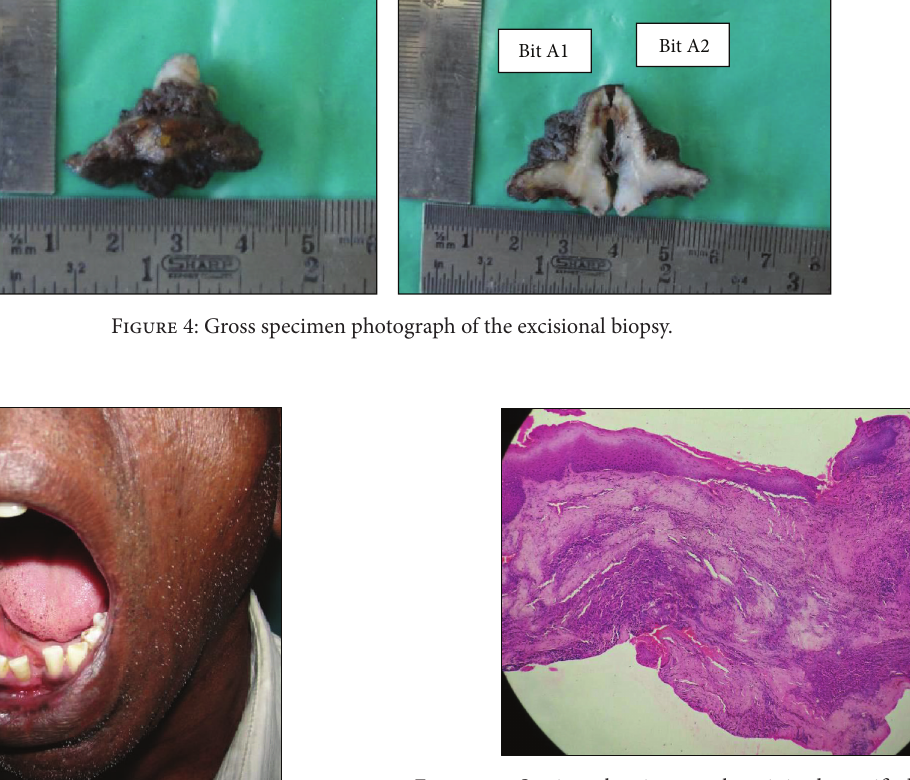
Figure 7: Section showing parakeratinized stratified squamous epithelium with cartilaginous islands and inflammatory cell infiltra- tion in the connective tissue stroma (H&E 20x).